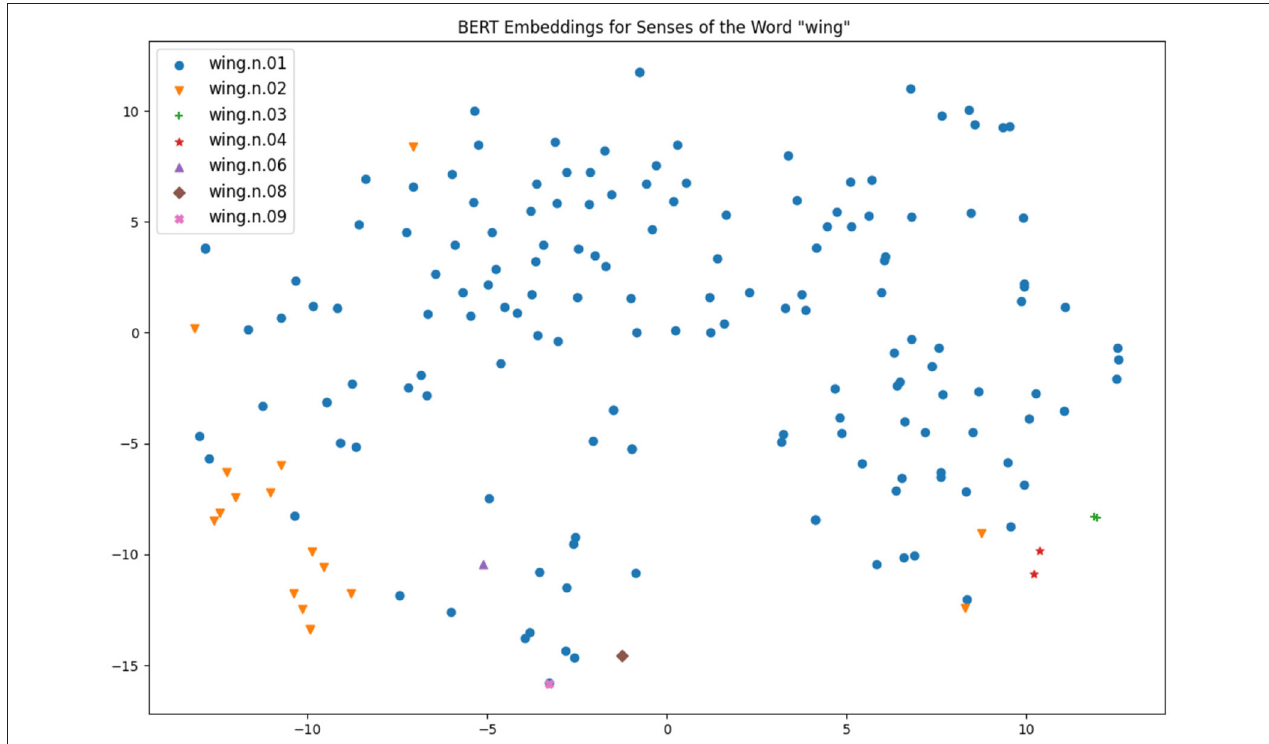
FIGURE 4 | Visualizations of BERT embeddings for different uses of